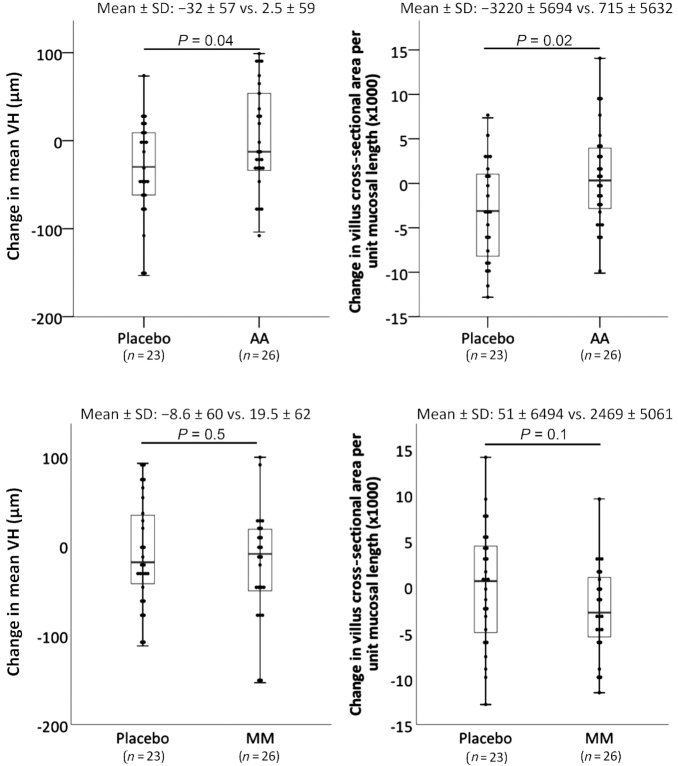
Change in VH and villus cross-sectional surface area per unit length of mucosa after AA (top panels) or MM (bottom panels) supplementation compared with placebo. Mean ± SD changes are given together with Tukey's hinges. Two-tailed independent-samples t test, with normality confirmed by the Shapiro–Wilk test. AA, amino acid; MM, multiple micronutrient; VH, villus height.